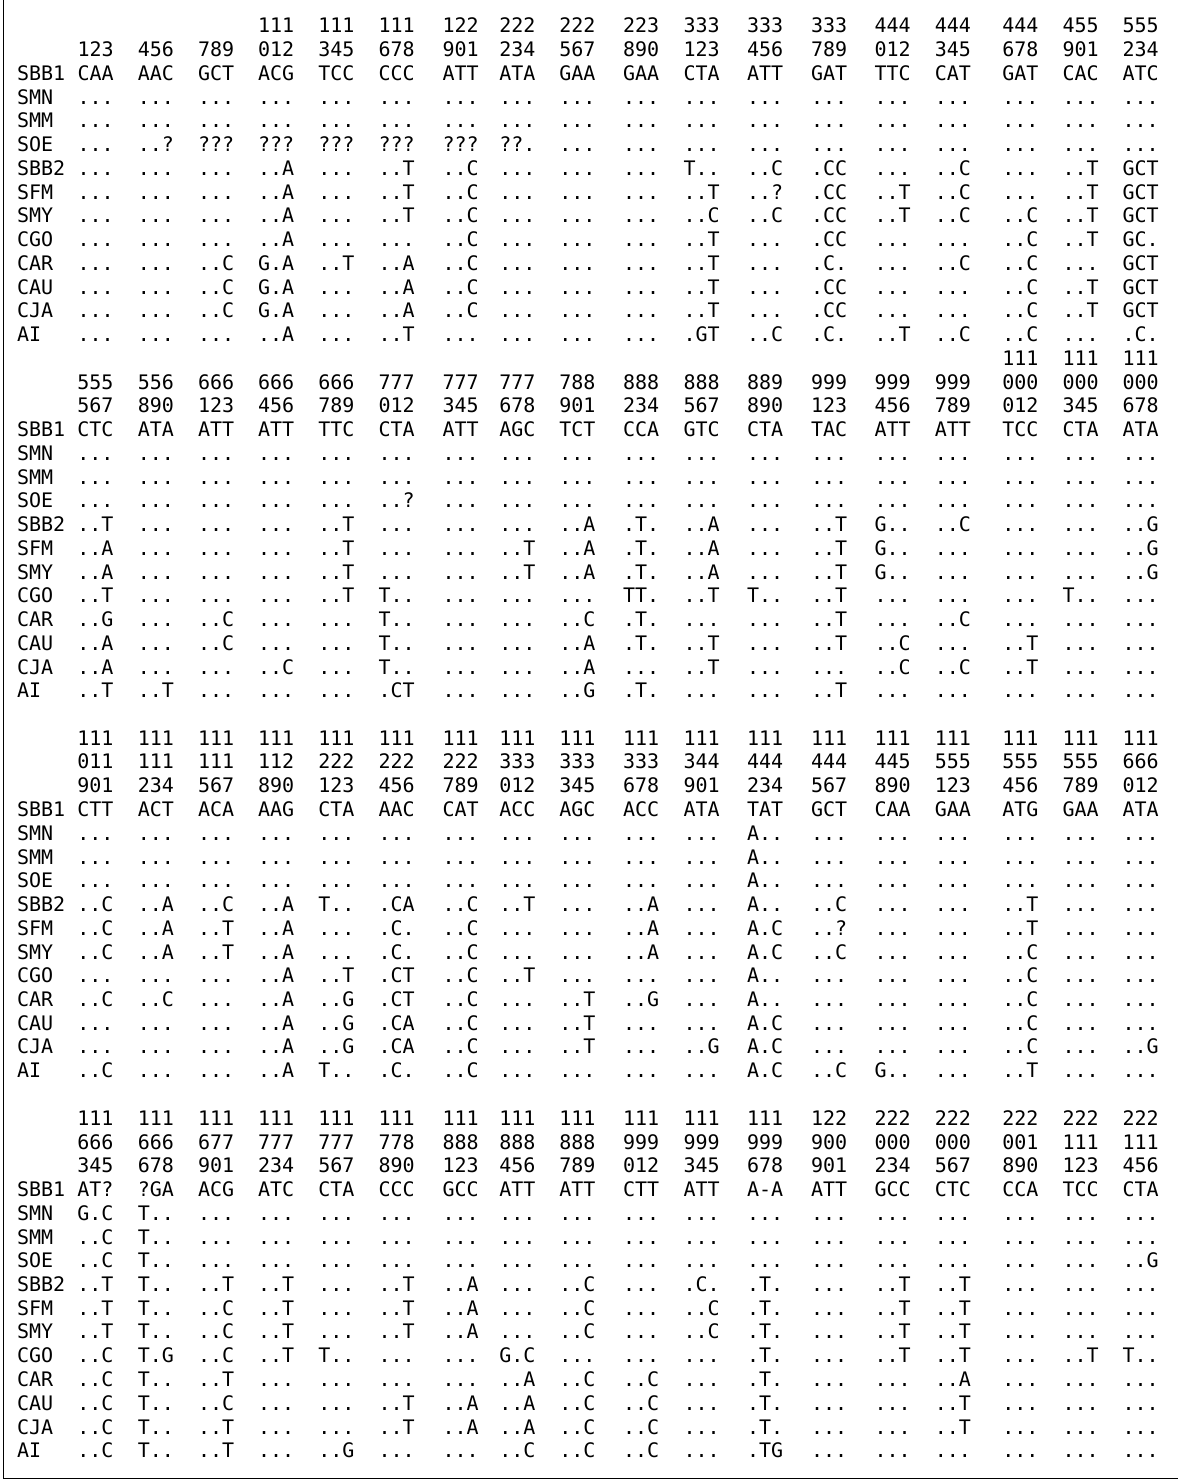
Figure 1 - Alignment of 549 base pairs of the cytochrome c oxidase subunit II (COII) mitochondrial gene in four New World primate genera ( Saguinus , Callithrix , Callimico and Aotus ). Dots indicate nucleotides identical to Saguinus bicolor bicolor (SBB1), “?” indicates missing data and “-” represents an insertion or deletion. SMM = S. m. midas , SMN = S. m. niger, SBB1, SBB2 = S. b. bicolor, SOE = S. oedipus , SMY = S. m. mystax , SFM = S. f. melanoleucus , CJA = C. jacchus , CAR = C. argentata , CAU = C. aurita , CGO = Callimico goeldi , and AI = Aotus infulatus